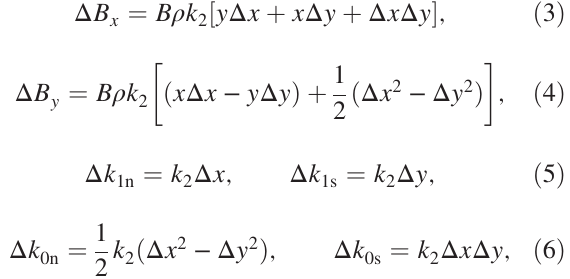
FIG. 20. Optimal distance L as a function of the FFS length.